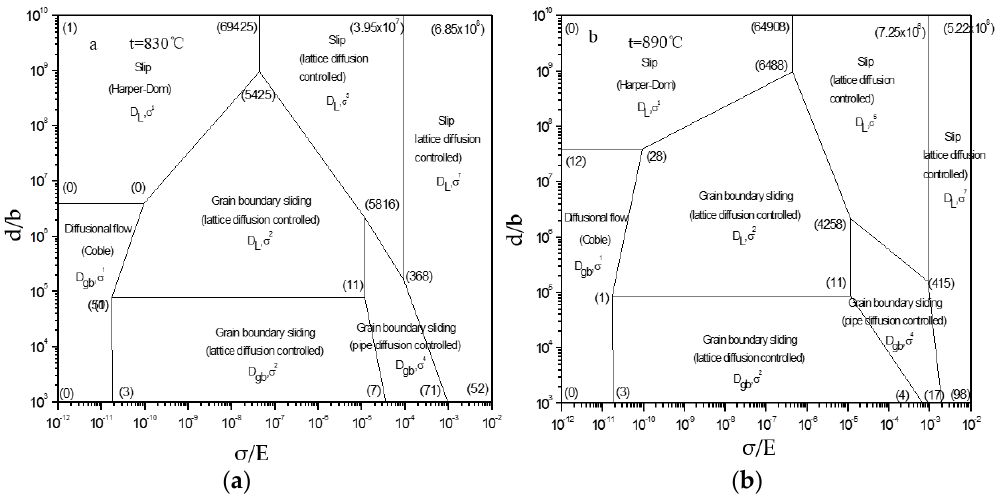
Table 5. Calculated results for hot compression deformation of the Ti–6Al–4V alloy.